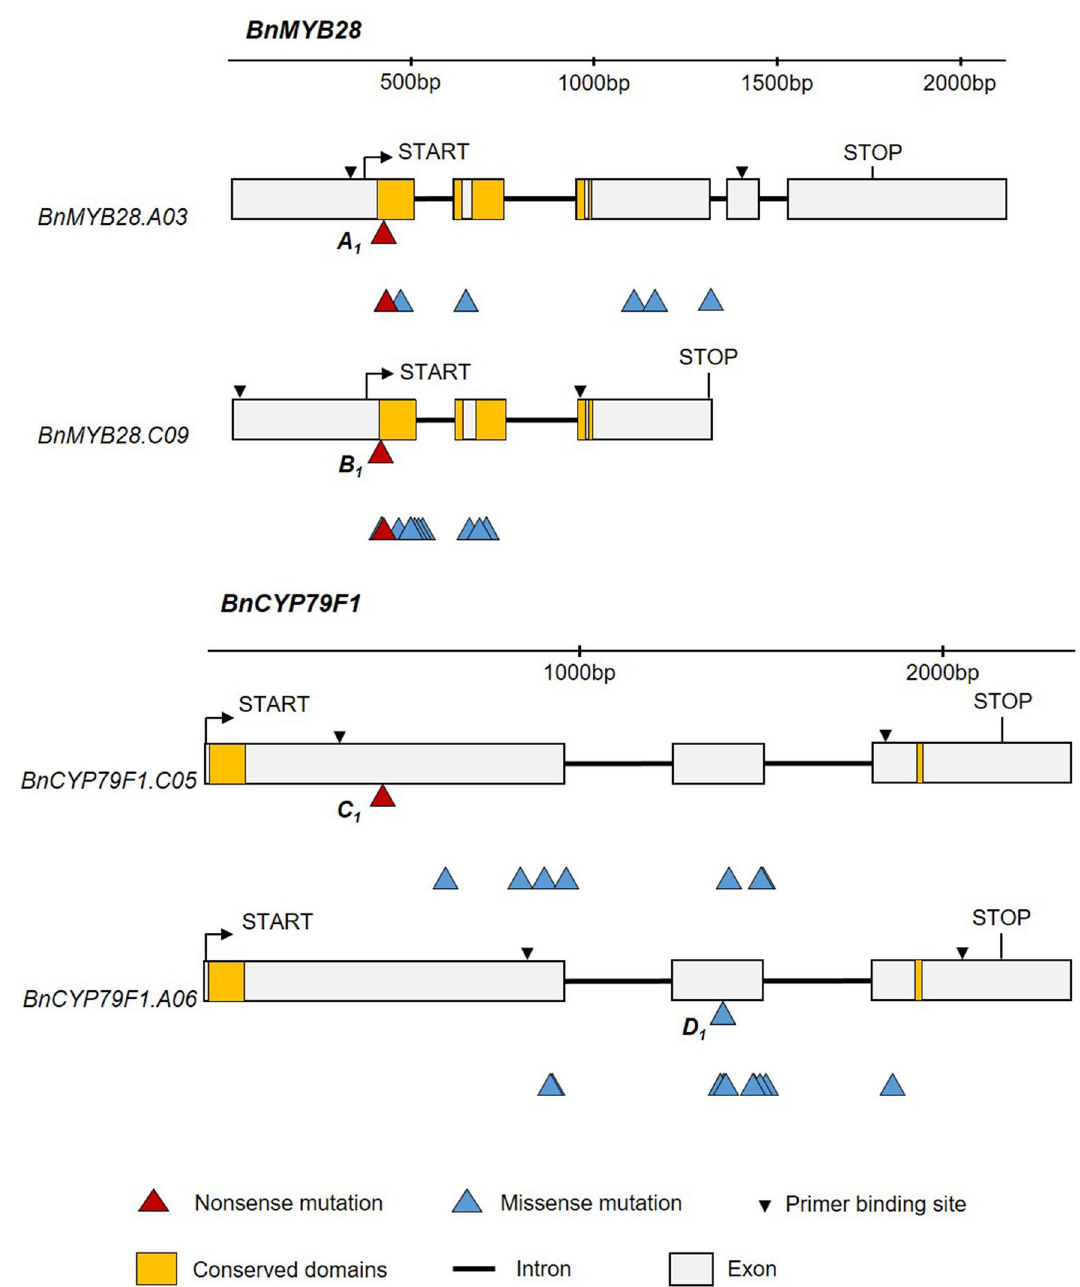
Figure 2. Structure of four BnMYB28 and BnCYP79F1 genes and positions of EMS-induced nonsense and missense mutations. Allele identities are given next to the mutation site for those mutations used for further studies (refer to Table 2 for all allele codes). Regions coding for functional and conserved domains characteristic to the gene families are marked in orange boxes. START and STOP represent the translation start and stop sites, respectively. For BnCYP79F1 , the 5 ʹ untranslated regions are not defined on the Darmor- bzh reference genome